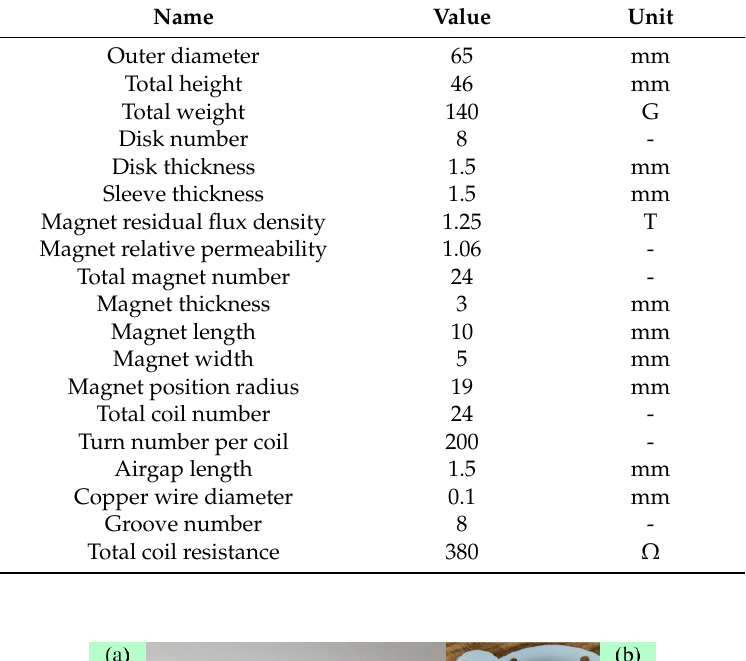
Table 1. Main parameters of the prototypes.